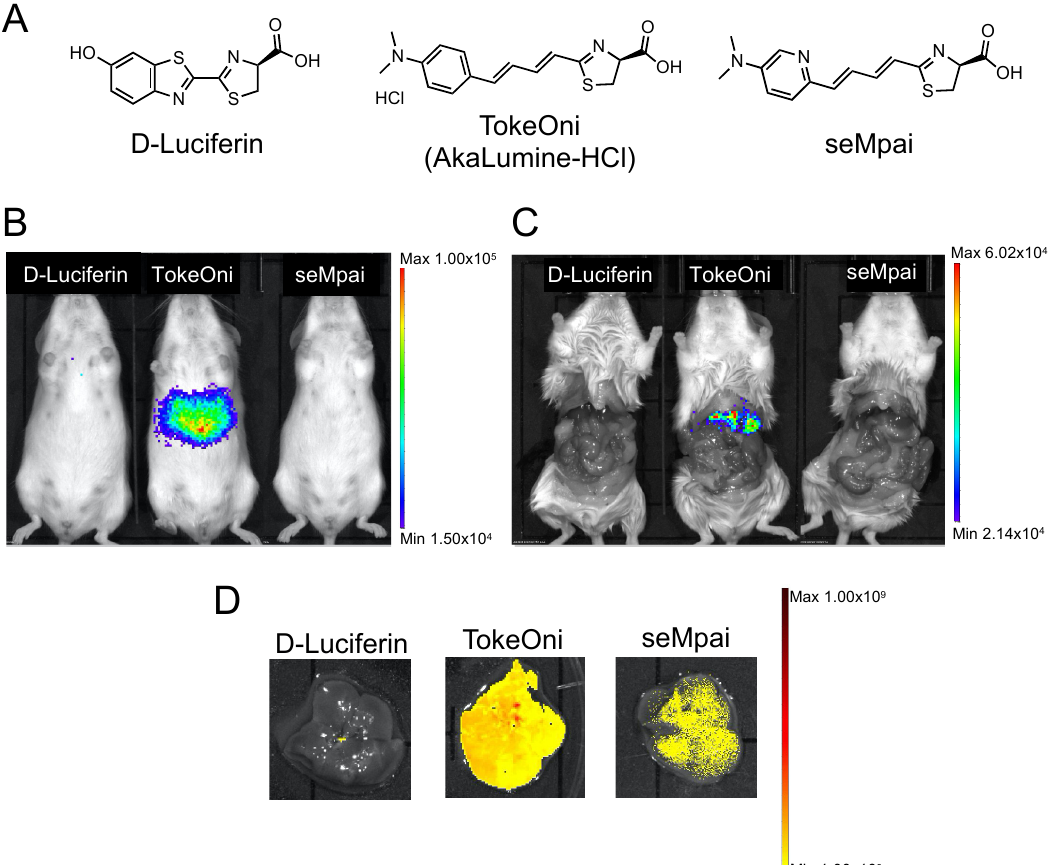
Figure 1. Hepatic background signals of luciferin analogues. Structural formulae of firefly D-luciferin and luciferin analogues ( A ). Bioluminescence imaging (BLI) of D-luciferin and luciferin analogues using non-transplanted female mice ( B ). BLI in mice with an open peritoneum ( C ). Ex vivo fluorescence imaging of the harvested livers using a 670 nm emission filter and an open excitation light ( D ). The scale bar’s unit is the radiance (p/s/cm 2 /sr).